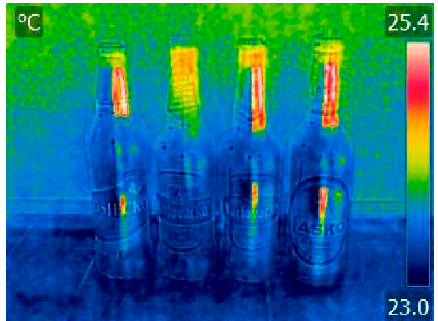
Figure 1. Infrared thermographic recordings of samples. Glasses (0.5 L; generic brand, model Lilith, h = 185 mm, Ø = 0.75 mm) were washed, tical and left to cool down at room temperature prior to analysis, which can be seen from Figure 2. Values of the thermogram legend are set by the infrared thermal camera, according to the registered radiation.